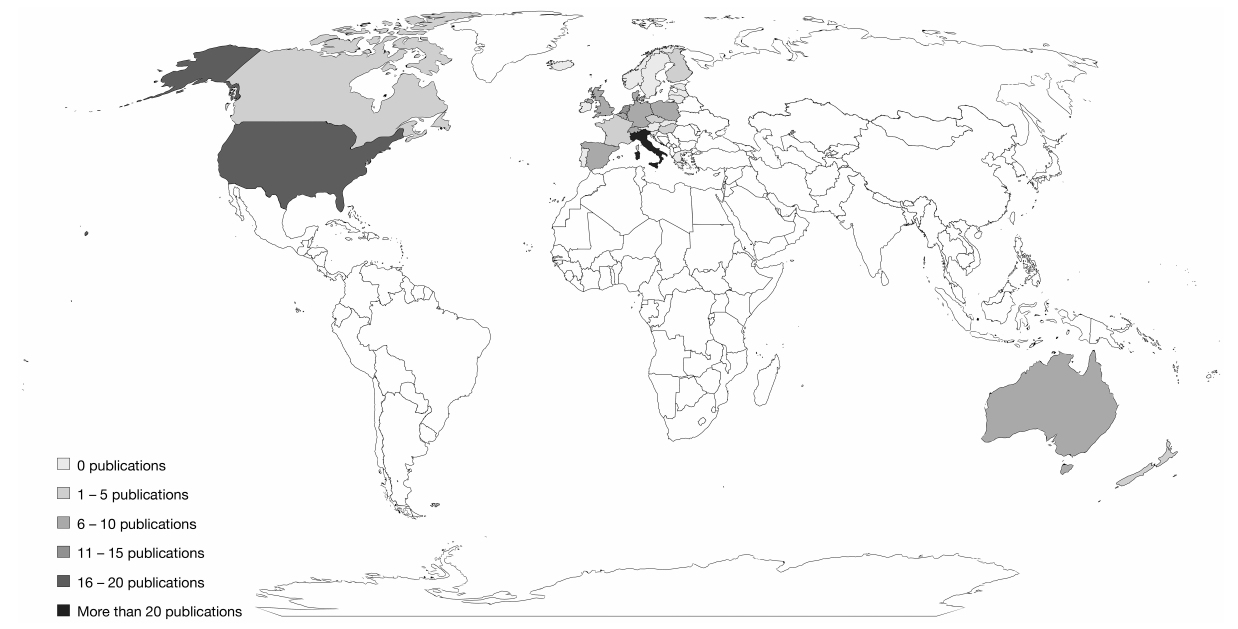
Frontiers in Nutrition |